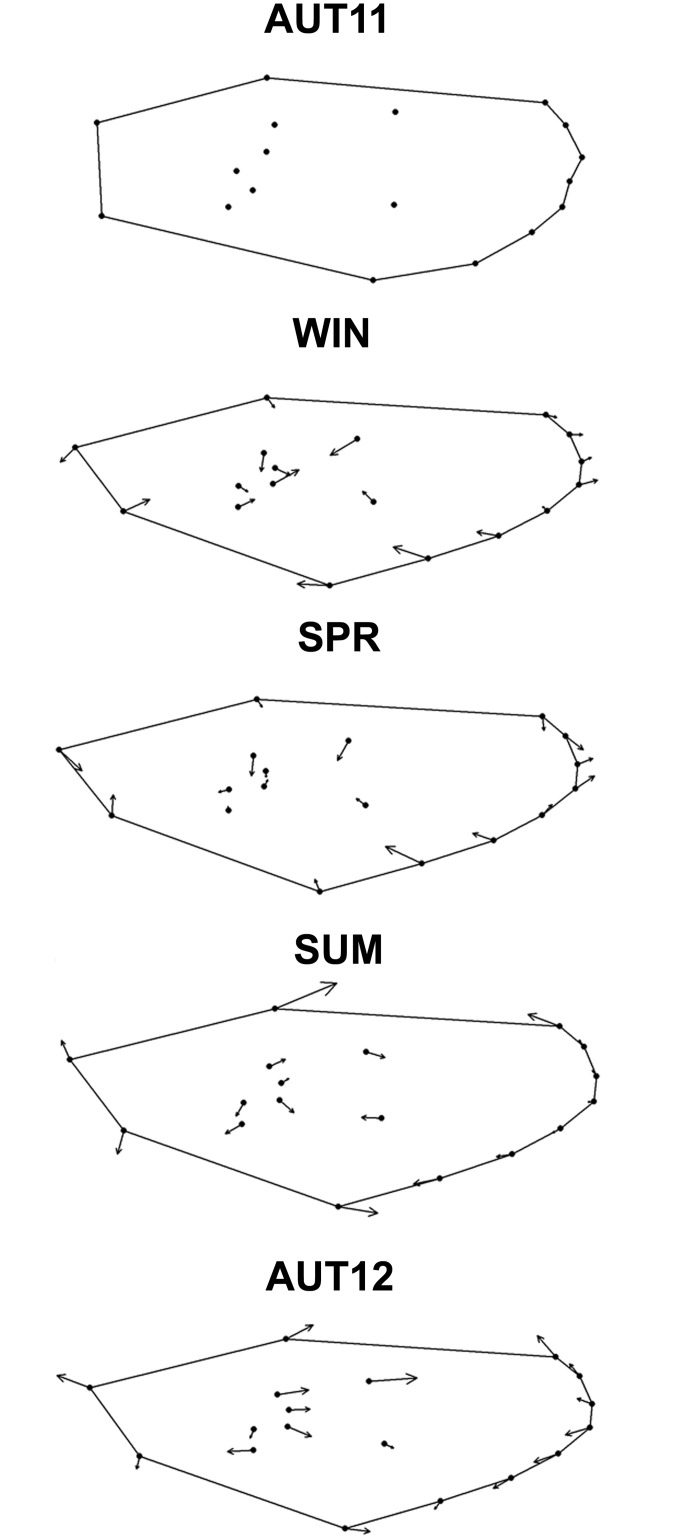
Wing shape temporal variations represented by thin-plate splines.Only the 18 landmarks, the wing outline and deformation vectors are shown. In each chronological sample depicted variations are relative to the previous sample. Deformations were magnified 10X to facilitate visualization.